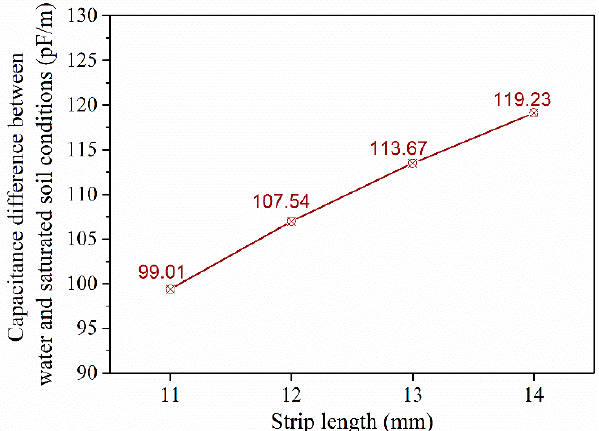
Figure 9. Capacitance difference obtained between water and saturated soil conditions for various electrode lengths of 11, 12, 13 and 14 mm. Increased electrodes lengths resulted in a corresponding increase in the capacitance difference computed between the two simulated conditions.